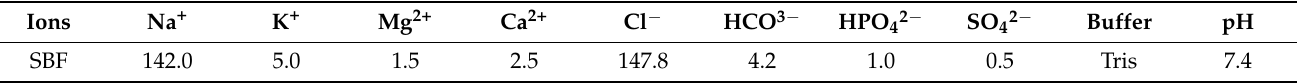
Table 1. Composition of simulated body fluids/(mmol · L − 1